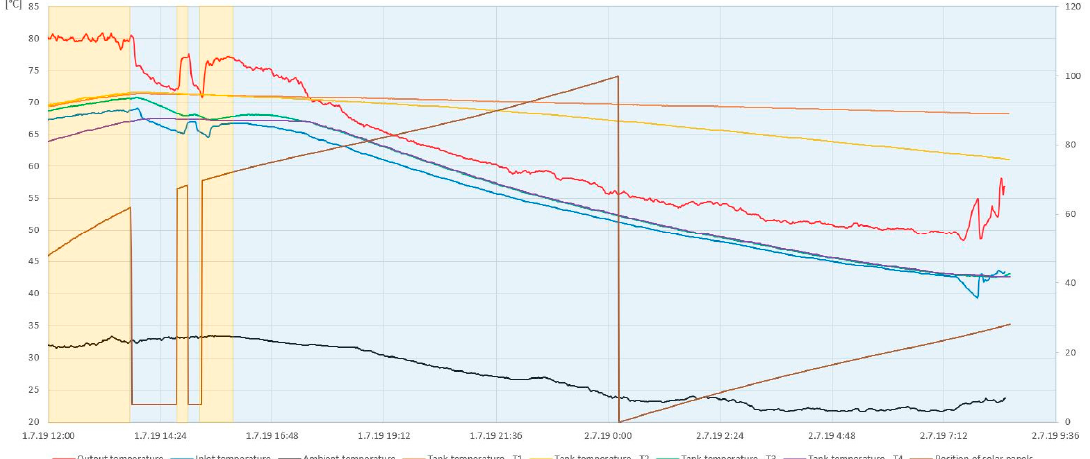
Figure 17. Influence of panel tilting on the system temperatures and liquid cooling process in the tank. Processes 2020 , 8 , x FOR PEER REVIEW